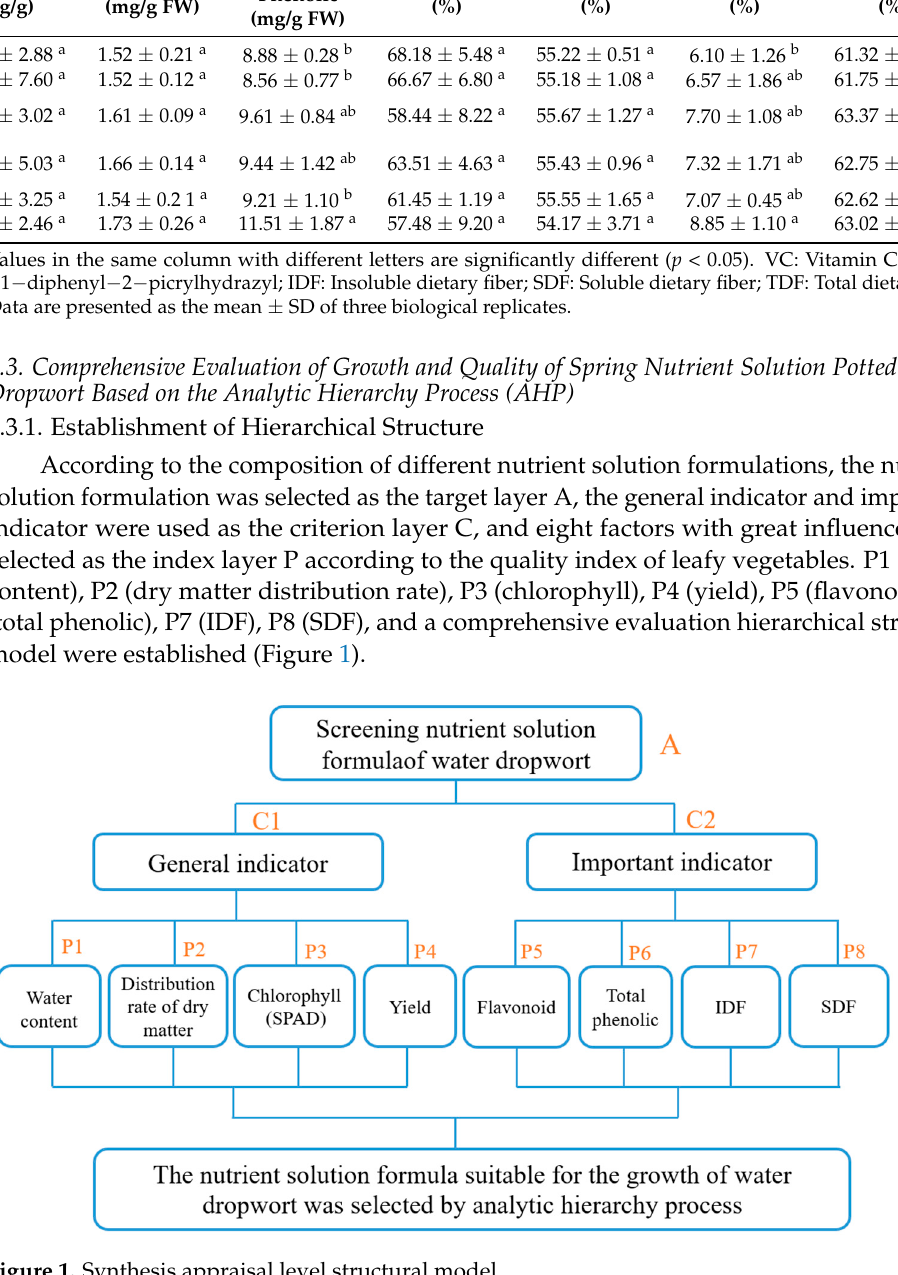
Figure 1. Synthesis appraisal level structural model.